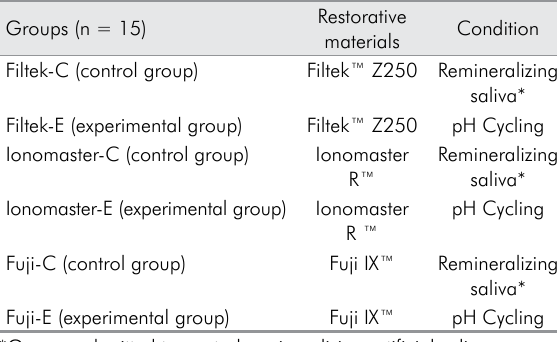
Table 1. Samples of composite resins (CR) and glass-iono- mer cement (GIC) in control (C) and experimental (E) condi- tions Groups (n = 15)